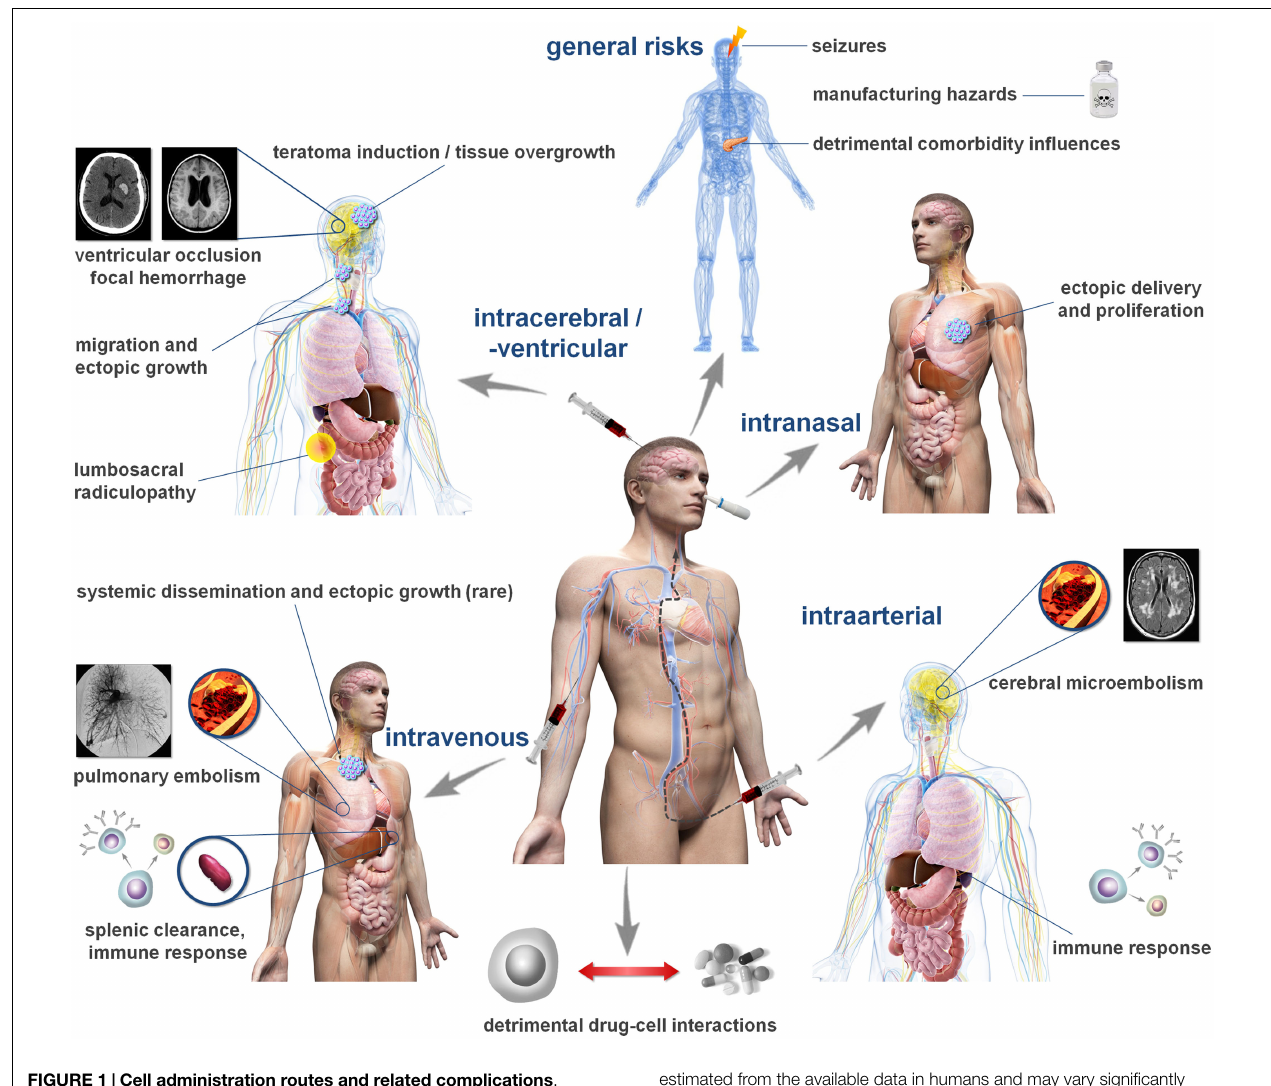
FIGURE 1 | Cell administration routes and related complications . The figure depicts common routes investigated for cell and stem cell transplantation following stroke and potentially associated complications. The frequency of such complications can hardly be